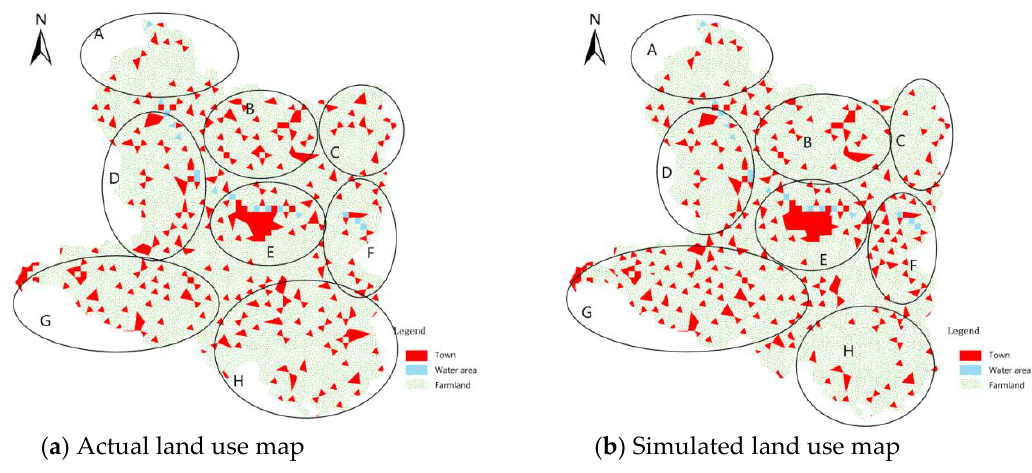
Figure 8. The actual and simulated land use maps of Dengzhou city for 2015.